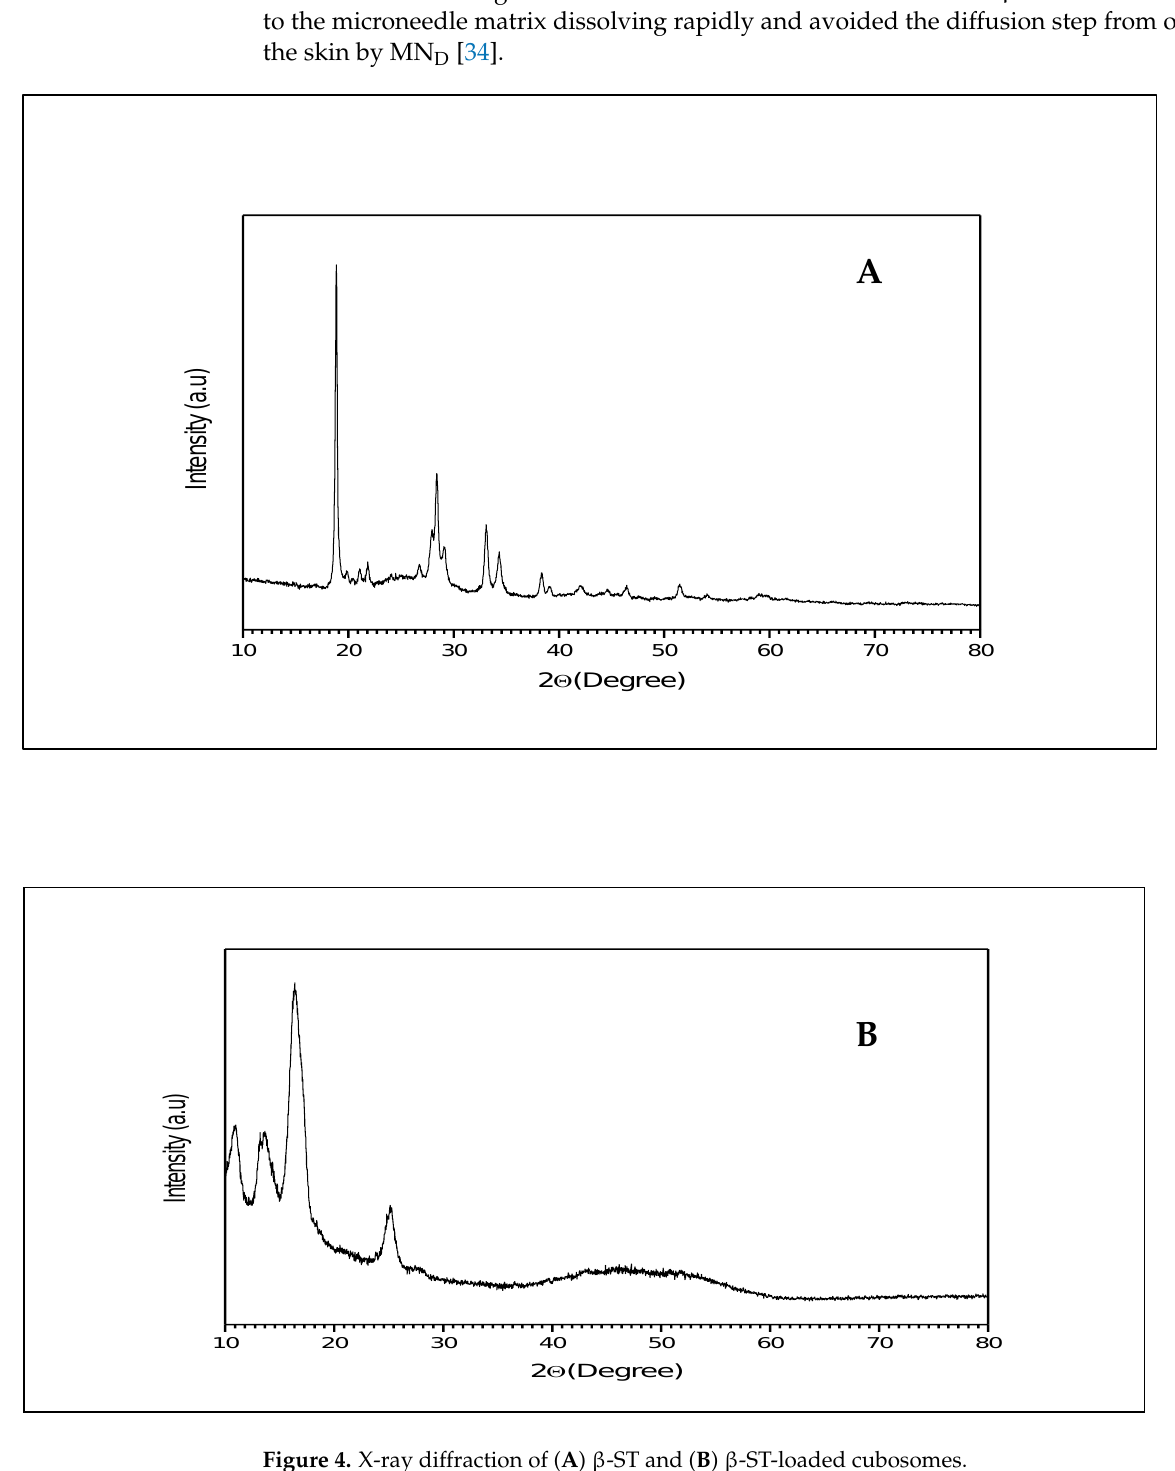
Figure 4. X - ray diffraction of ( A ) β - ST and ( B ) β - ST - loaded cubosomes. Figure 4. X-ray diffraction of ( A ) β -ST and ( B ) β -ST-loaded